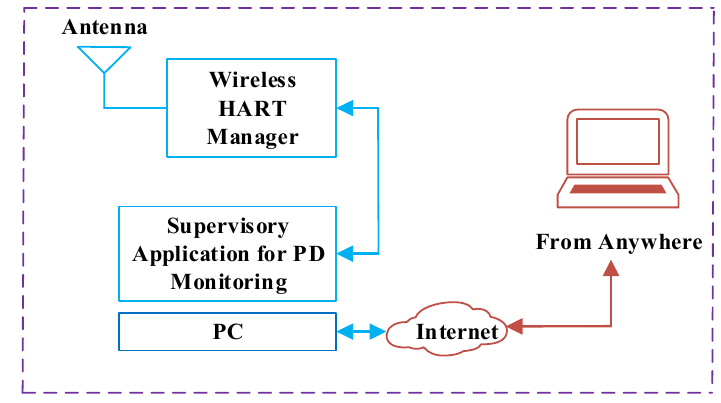
Figure 8. Overview of the supervisory system.